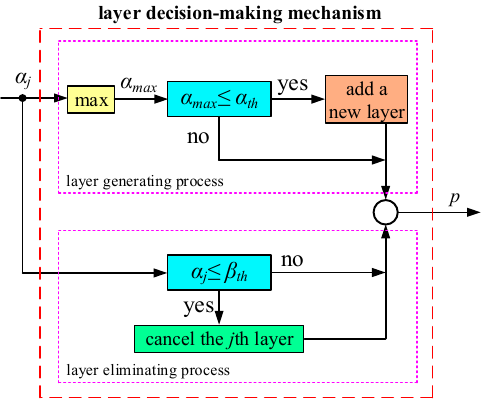
Figure 4. Layer decision-making mechanism.